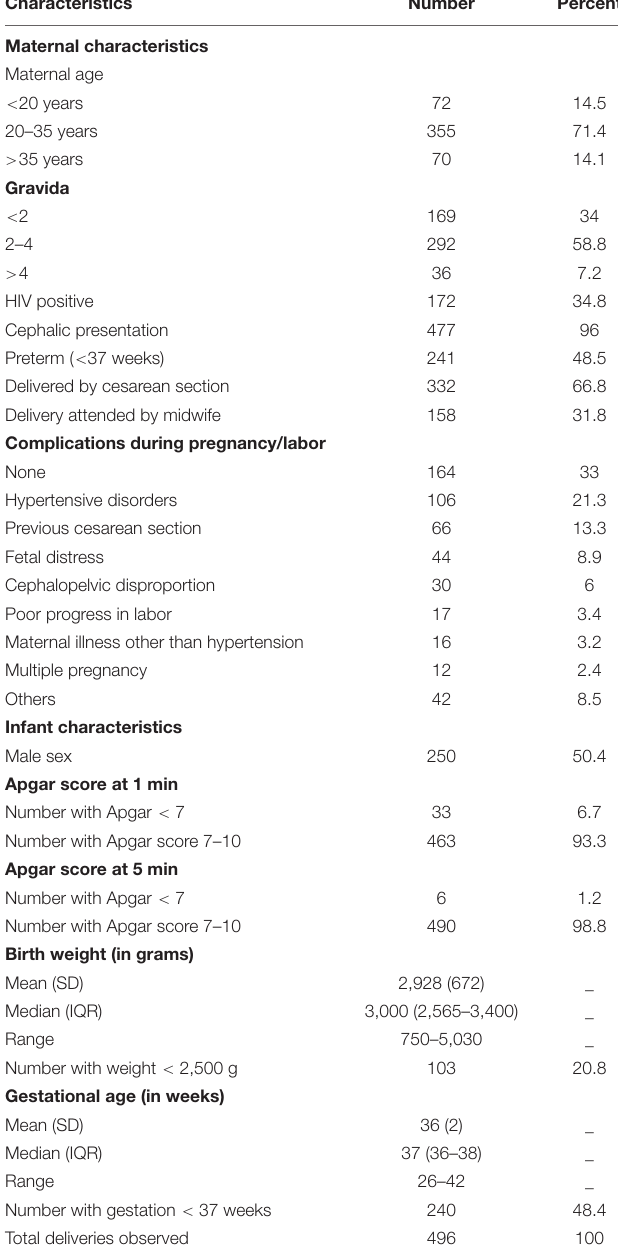
TABLE 1 | Maternal and infant